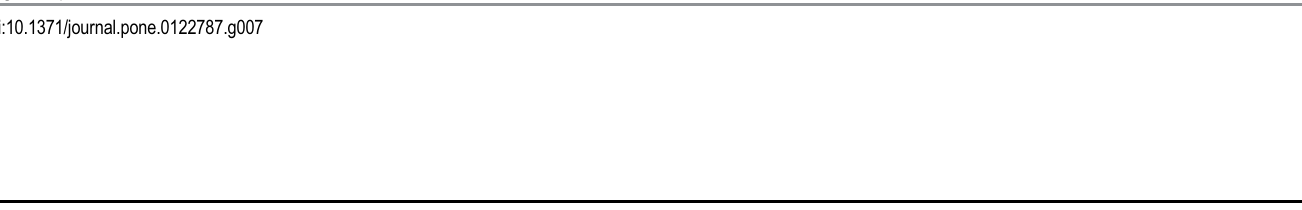
PLOS ONE | DOI:10.1371/journal.pone.0122787 April 2,